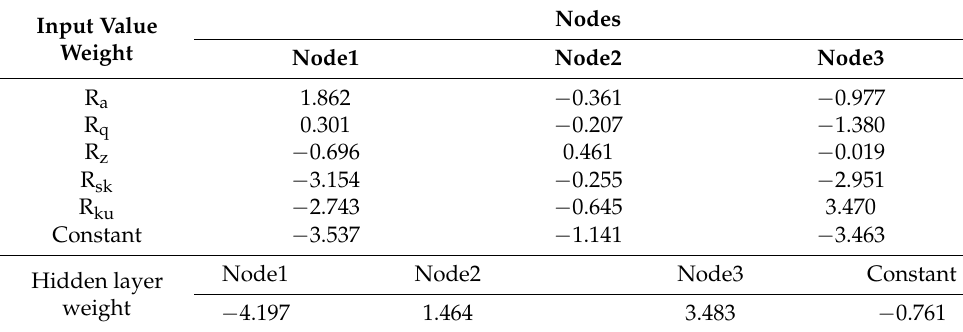
Table 10. Calculated model weights with BPN as the output